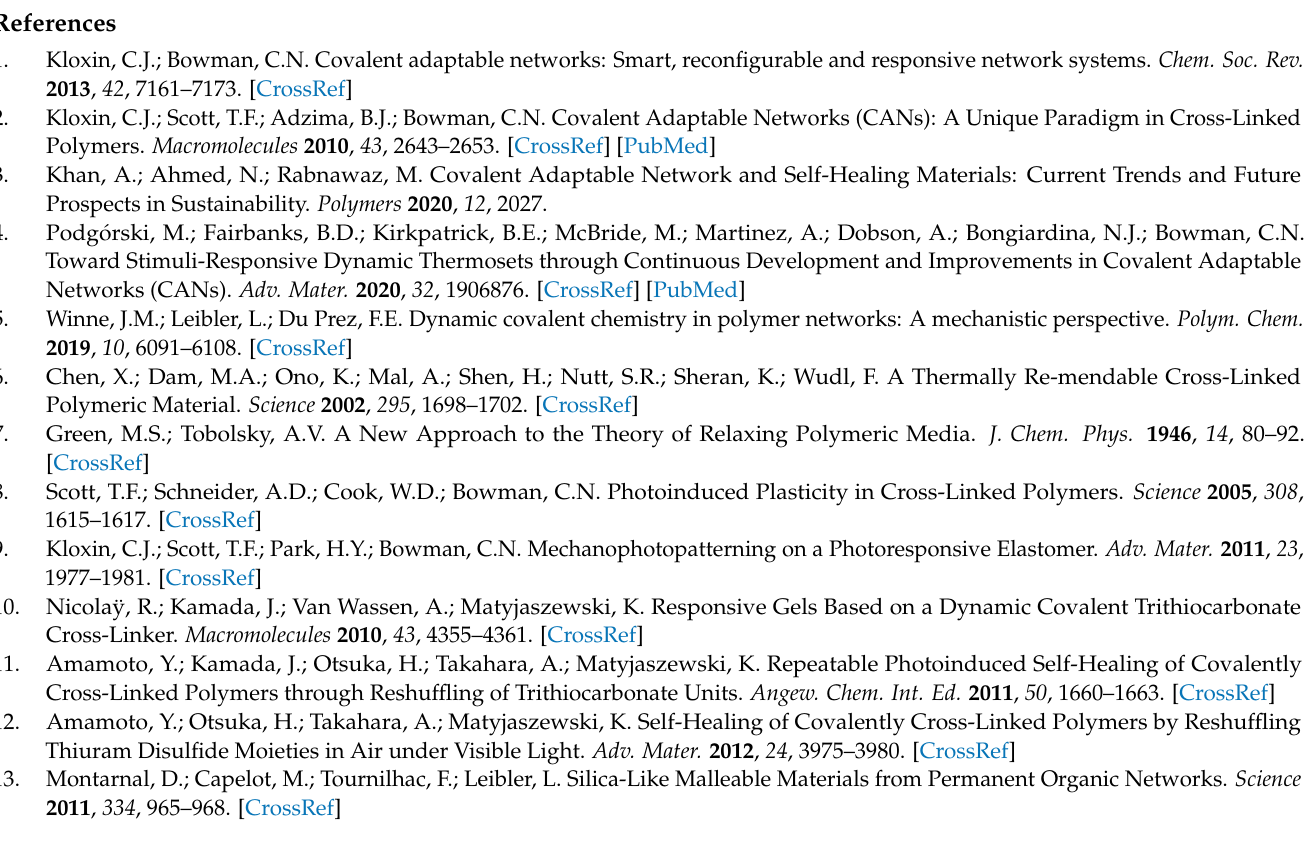
Vitrimer 3 and 4 . The possible structure of transesterification product obtained from Vitrimer 3 was shown on the top. 1 H NMR of soluble fraction from Vitrimer 3 with proton integration was shown in the right; Figure S5. ESI-TOF-MS of soluble fraction obtained from Vitrimer 3 . The chemical structure of component identified was shown and it was observed at m/z value of 877.5155. Bottom left figure showed isotopic pattern of peak at 877.5155 (black) which was well matched simulated pattern (red); Figure S6. Free induction decay (FID) and MSE refocused FID analyses of Vitrimer 3 at 100 ◦ C (A) and 180 ◦ C (B); Figure S7. G’ and G” plot vs shear strain of Vitrimers 3 (A) and 4 (B) measured at 180 ◦ C. Note that these measurements were done after experiments of Figure 7. The somewhat increased storage modulus may be due to settling of the sample in the rheometer tool and/or